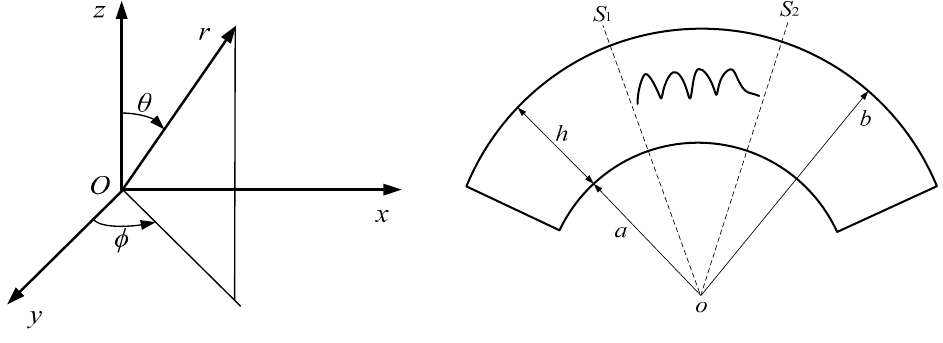
Figure 1. The model of the spherical curved plate.